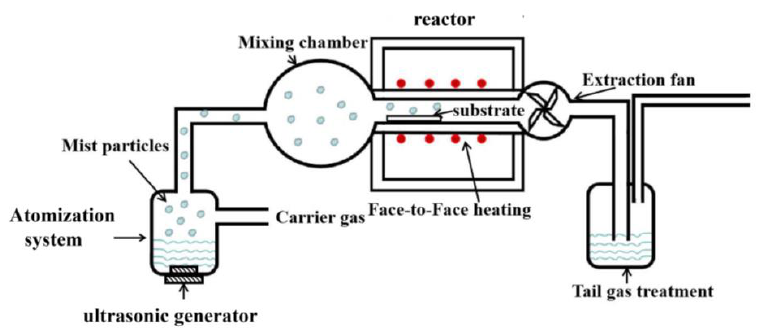
Figure 1. Mist-CVD face-to-face heating mist-CVD equipment system. Table 1. Film growth